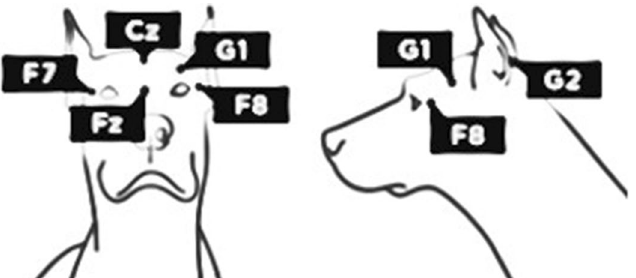
Figure 1. Schematic drawing (by Vivien Reicher) of electrode placement in the dog identical in study 1 & 2 (study 0 used the same electrode placement, but without the F7